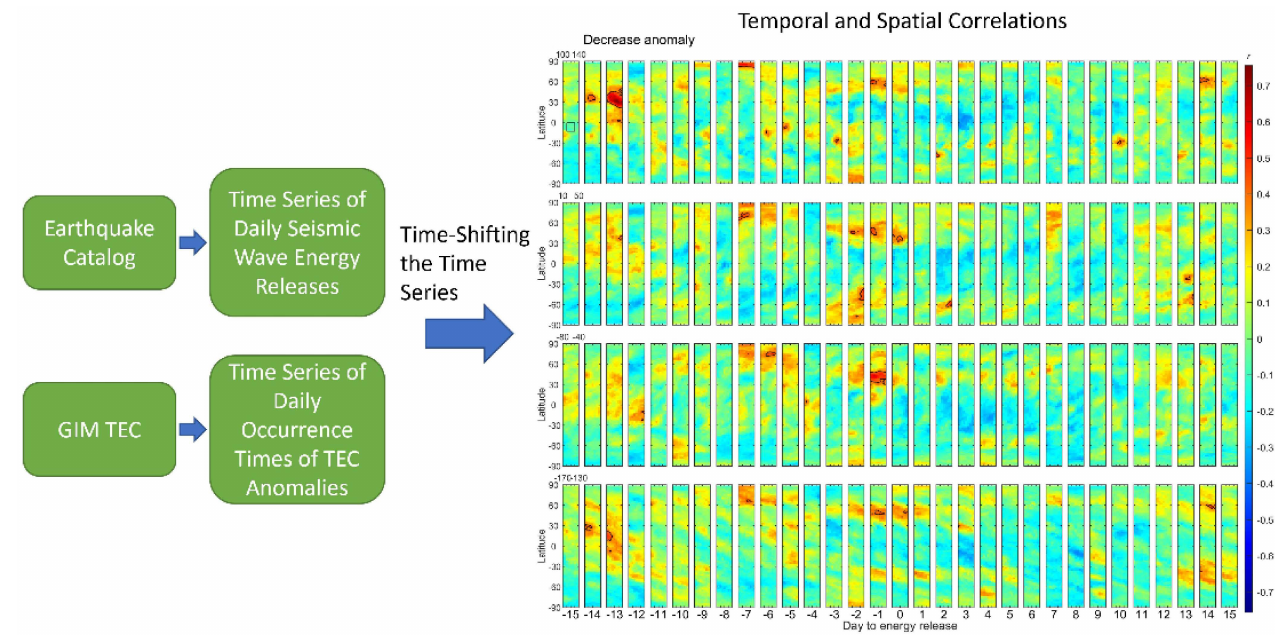
Figure 6. Temporal and spatial correlations